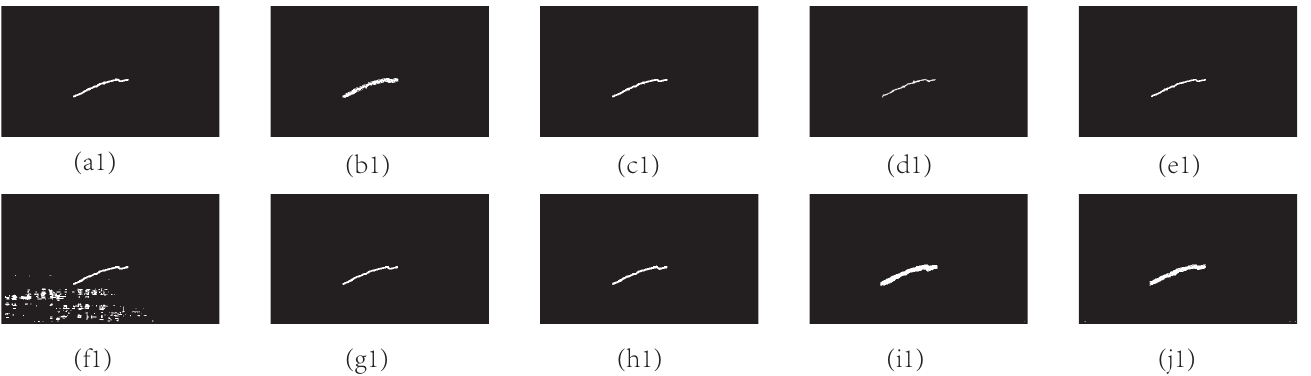
Figure 14. Panels ( a1 – j1 ) shows the detection results of sequence C of top hat, ANI, PSTNN, ASTTV, GST, NTFRA, NRAM, HB-MLCM, ADMD, and the proposed method.